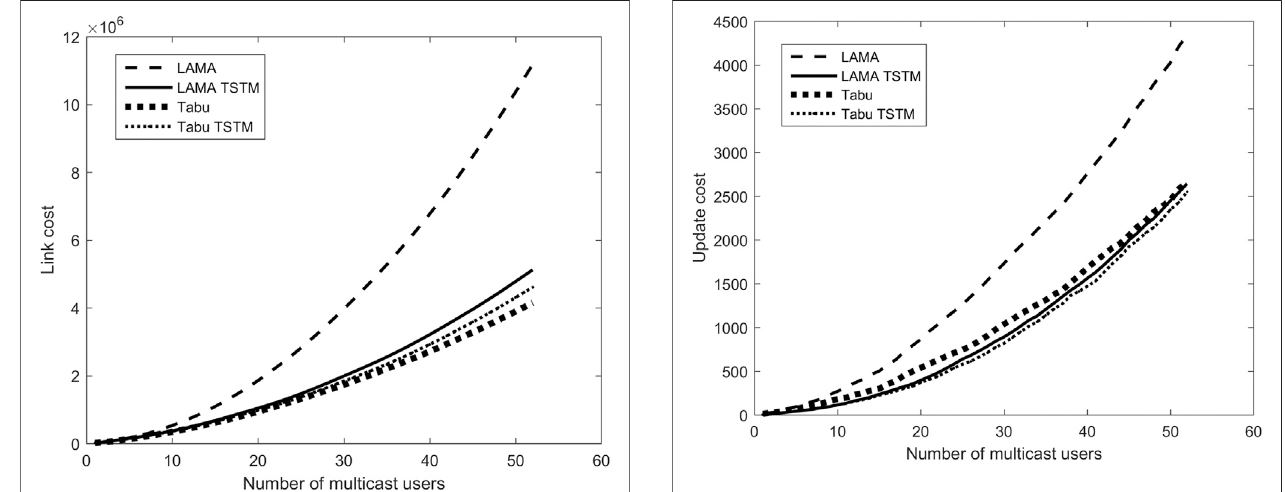
FIGURE 7 | The update cost of multicast trees on different